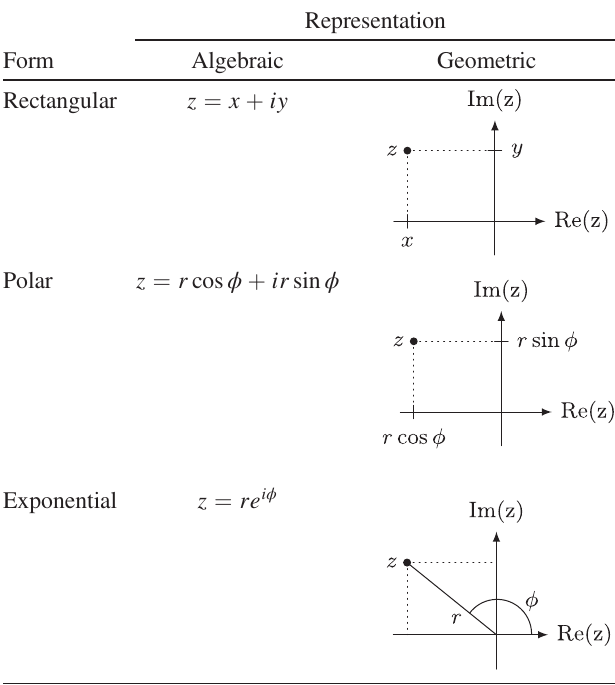
TABLE I. Algebraic and geometric representations of the complex number z in rectangular, polar, and exponential